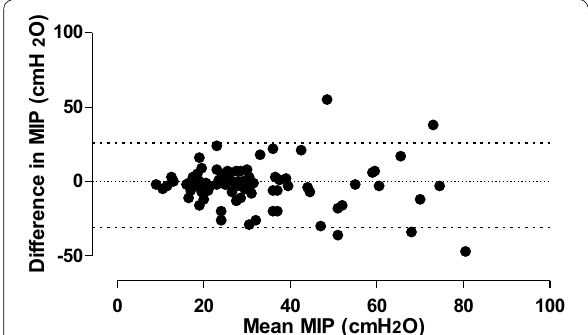
Fig. 1 Bland–Altman analysis of maximal inspiratory pressure correla- tions: difference versus